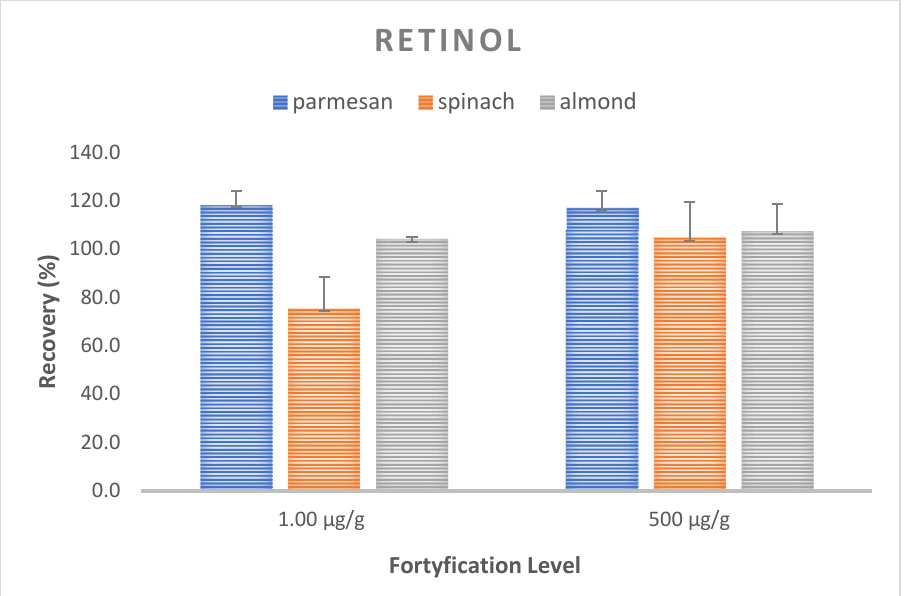
Figure 3. Recovery and CV values for vitamin A at two spiking levels for a matrix of Parmesan, spinach, and almonds.